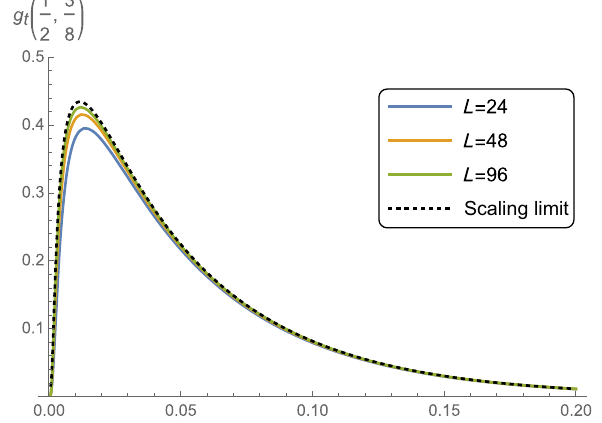
FIG. 5. Boundary conditions that do not fit the initial domain 1 = 2 , n 1 = 2 wall state ( n a ¼ b ¼